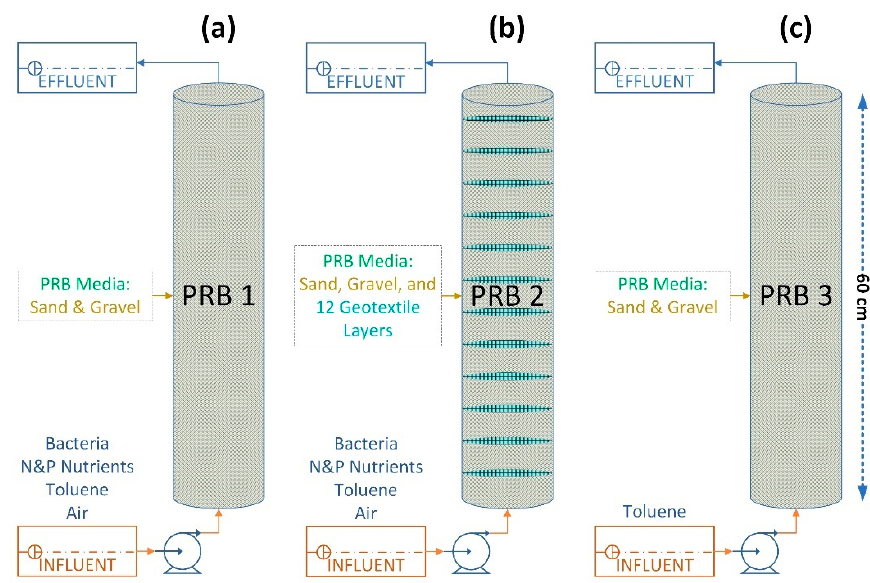
Figure 1. Schematics of PRB columns: ( a ) Bioaugmentation and biostimulation process (BA + BS), ( b ) bioaugmentation/biostimulation process and 12 layers of geotextile (BS + BA + Geotextile), ( c ) natural attenuation process (NA).